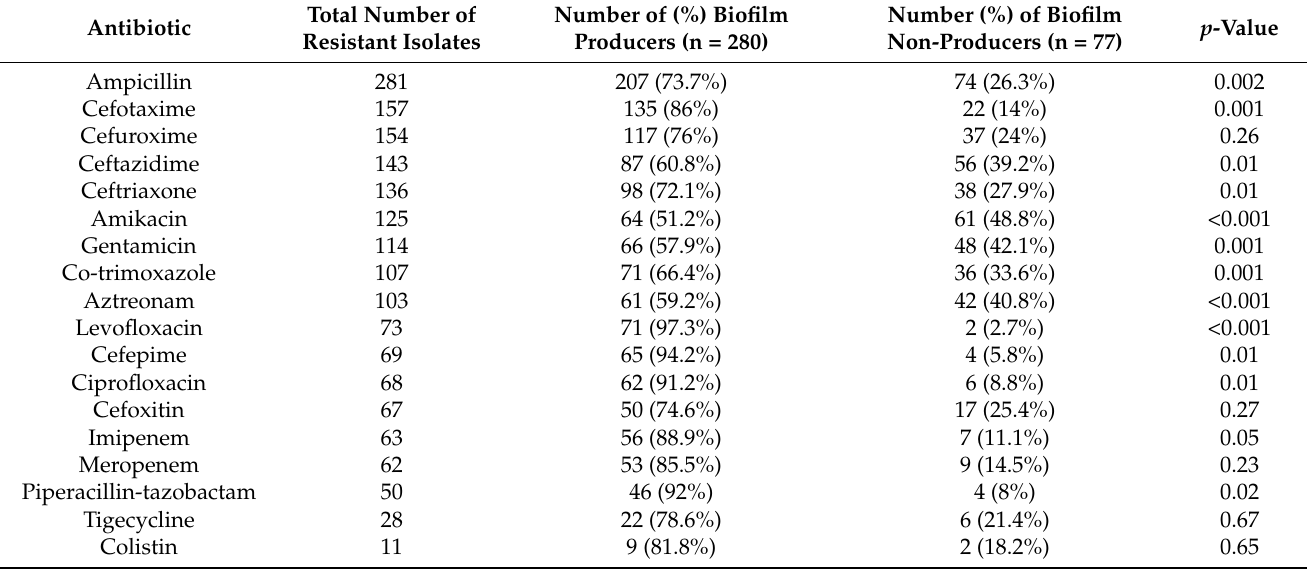
Table 4. Antimicrobial resistance of biofilm-producing and biofilm-non-producing isolates (n = 357).